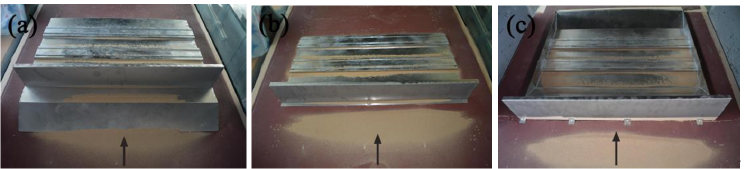
Figure 13. Sand particle sedimentation on the leeward sides of three wind-break walls: ( a ) convex subgrade, ( b ) flat subgrade, and ( c ) concave